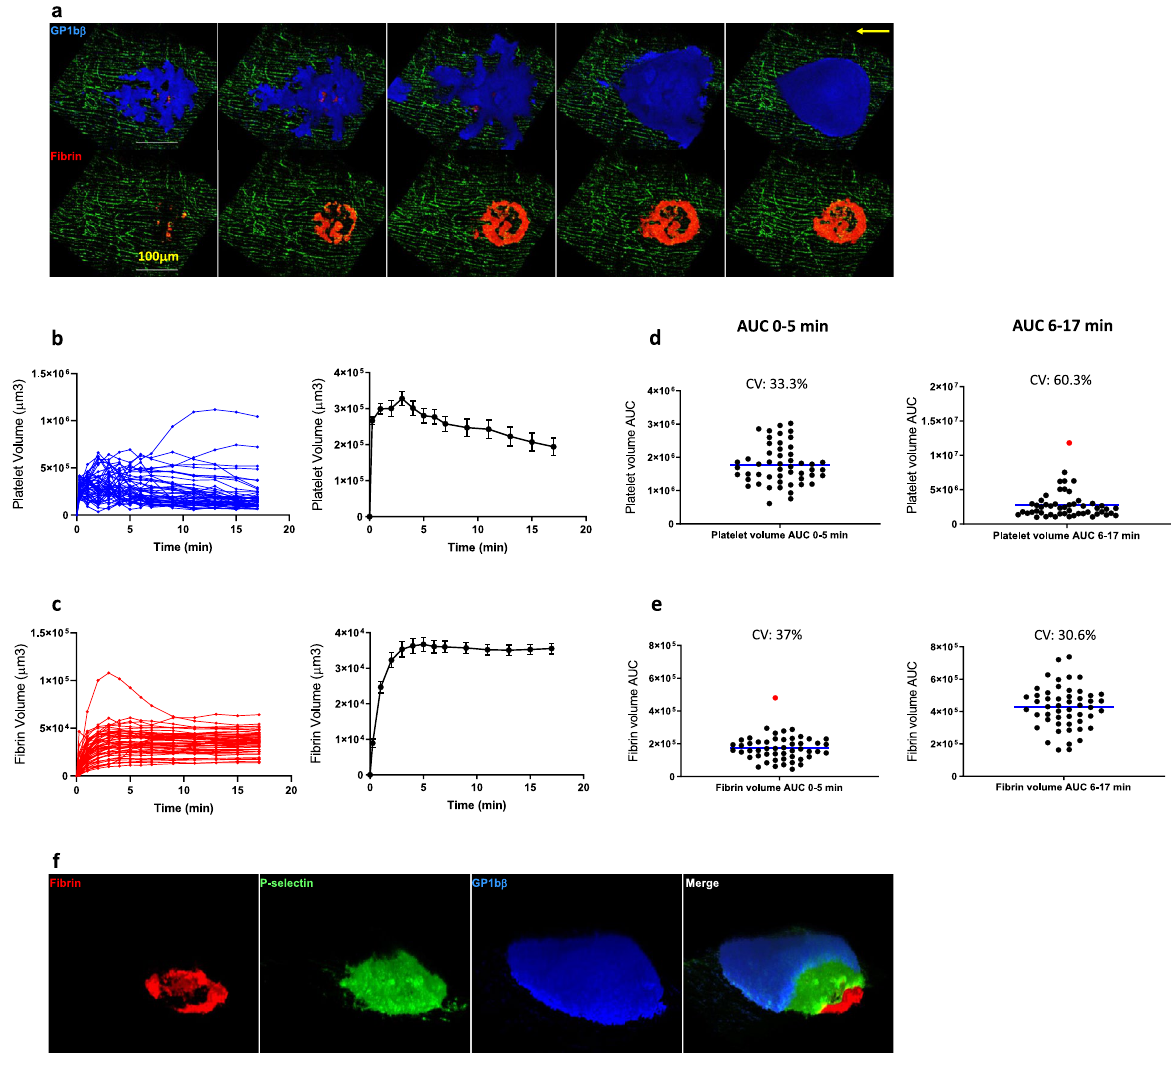
Figure 5. Scanning-LIEI causes dynamic platelet accumulation and results in reproducible thrombi with core–shell architecture. The formation of a thrombus after vessel injury was followed over time. ( a ) XY 3D reconstruction (surface rendering) of platelet (top panel) and fibrin (lower panel) structure at different time- points after scanning-LIEI (0.3 min, 1 min, 3 min, 5 min, 15 min). Platelets are shown in blue and fibrin in red. Scale bar = 100 um. See also Supplementary Video 1. ( b ) Platelet volume over time (0–17 min). Each injury is plotted in the left panel and mean (+/− SEM) is shown in the right panel. ( c ) Fibrin volume over time (0–17 min). Each injury is shown in the left panel and mean (+/− SEM) is shown in the right panel. ( d ) Scatter plot showing the distribution of cumulative platelet volume (area under the curve (AUC)) during the growth phase (0–5 min, left panel) and the maturation phase (6–17 min, right panel). ( e ) Scatter plot showing the distribution of cumulative fibrin volume (area under the curve (AUC)) during the growth phase (0–5 min, left panel) and the maturation phase (6–17 min, right panel). n = 51 injuries (37 mice). Data points determined to be outliers are shown in red. The mean and the Coefficient of variation (CV) is displayed in each scatter plot. ( f ) 3D reconstruction surface rendering of a representative thrombus 50 min after injury. The first three panels show the individual fluorescence channels (fibrin (red), P-selectin (green) and GpIb (blue)), and the fourth panel show a partial “peel-back” of each channel uncovering a core–shell structure with fibrin mainly present at the injury site, a core of P-selectin positive platelets and a shell of P-selectin negative